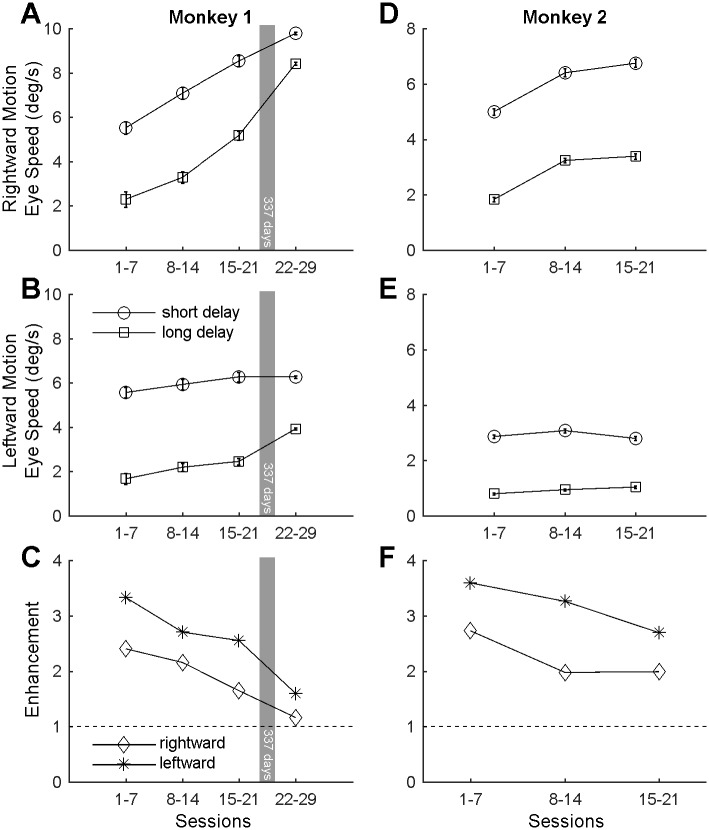
Initial eye speeds of the two monkeys over sessions.A,B. Mean ocular following eye speed for monkey 1 for rightward (A) and leftward (B) image motion plotted against binned sessions following saccades to the center of the screen at short (circles) and long (squares) delays. Error bars represent 95% confidence intervals. D,E. The same plots for monkey 2. C,F. The ratio of ocular following speed for the short-delay versus the long-delay conditions (Enhancement, Eq 1) for rightward and leftward motion in monkey 1 (C) and monkey 2 (F). In general, ocular following eye speed was faster in the short-delay condition. Over time, initial ocular following eye speed increased such that this post-saccadic enhancement of the ocular following response was completely (monkey 1) or partly (monkey 2) abolished.